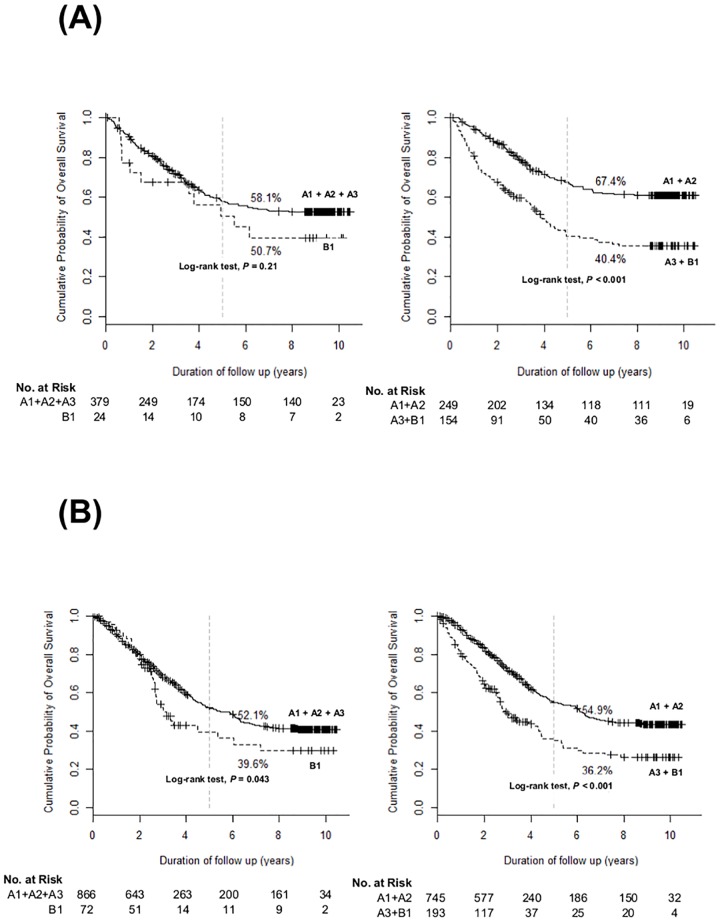
Overall survival of patients with liver cirrhosis (A) and those without liver cirrhosis (B) at baseline.